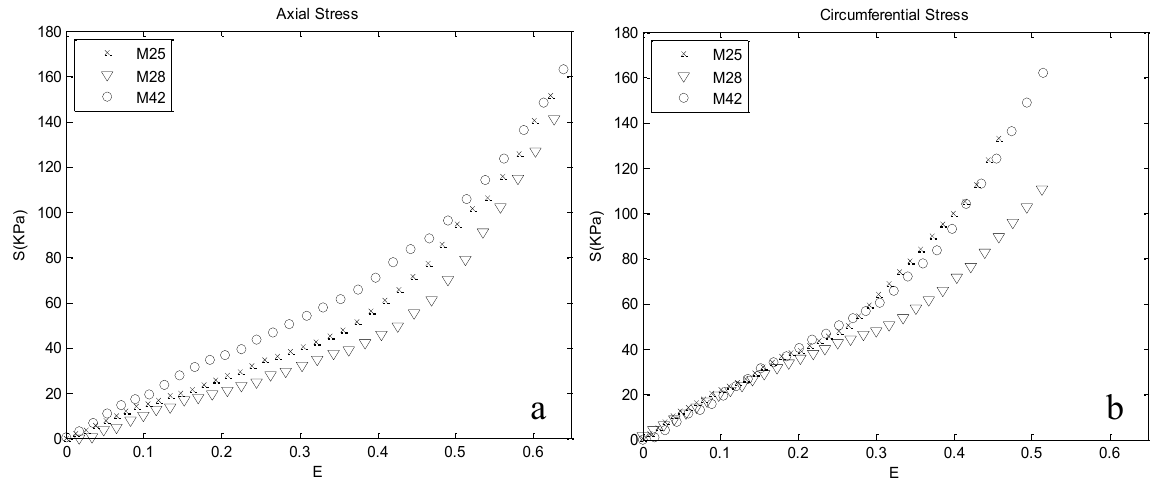
Figure 3. Stress-strain response obtained by biaxial tests: ( a ) axial and ( b ) circumferential responses. At low strain ranges, similar responses of the three cases in the axial and circumferential directions indicate that components leading to anisotropy do not contribute significantly in this region.